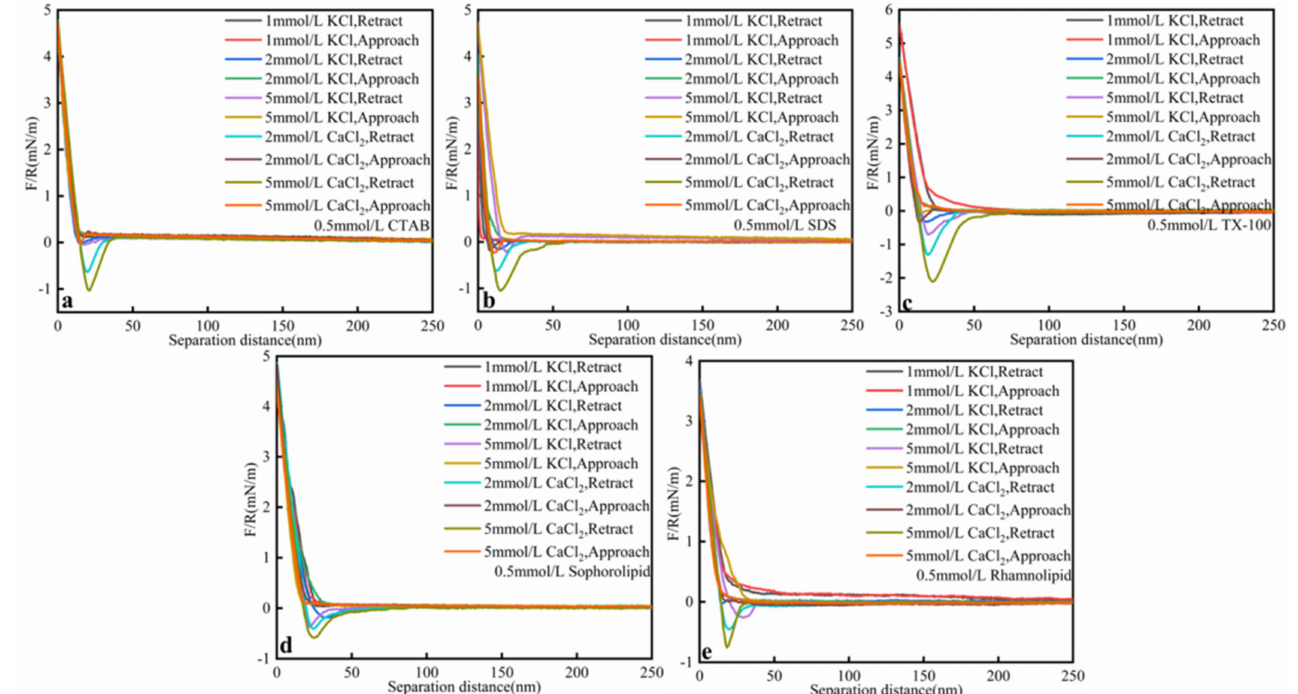
Figure 8. Interaction forces (F/R) between heavy oil and calcium carbonate at different salinities ( a ) CTAB; ( b ) SDS; ( c ) TX-100; ( d ) Sophorolipid; ( e ) Rhamnolipid solutions as a function of the separation distance at ambient conditions (0.01 mmol/L surfactants, 25 ◦ C, pH = 3.5, 45 ppm asphaltenes). Table 7. Adhesion forces (F/R, mN/m) between heavy oil and calcium carbonate in different salinities at ambient